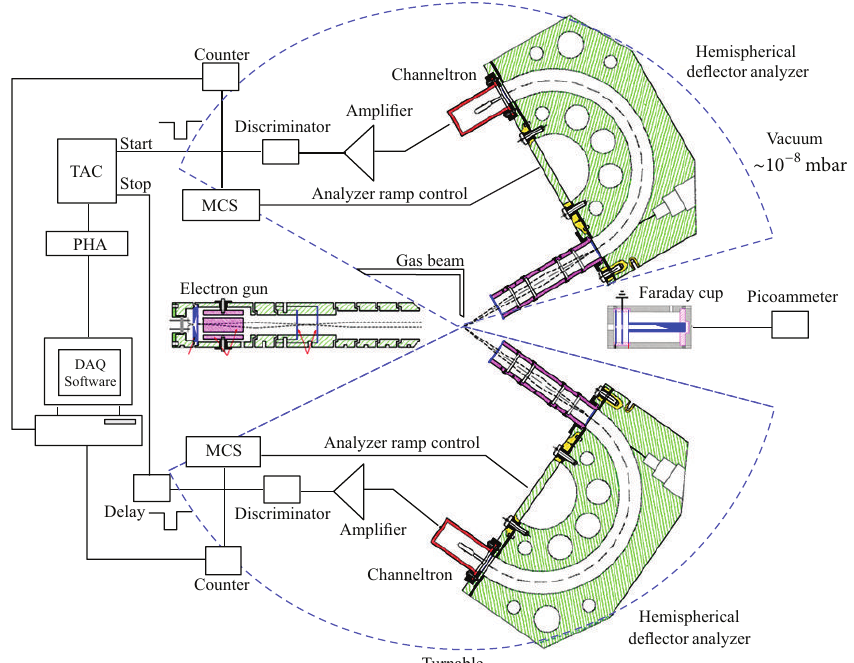
Figure 9: The electron gun, energy analyzers—mounted with detector (CEM)—, Faraday cup, and data accumulation circuit for measure- ments of DCSs, DDCSs and TDCSs used for electron impact ionization of the gas targets.